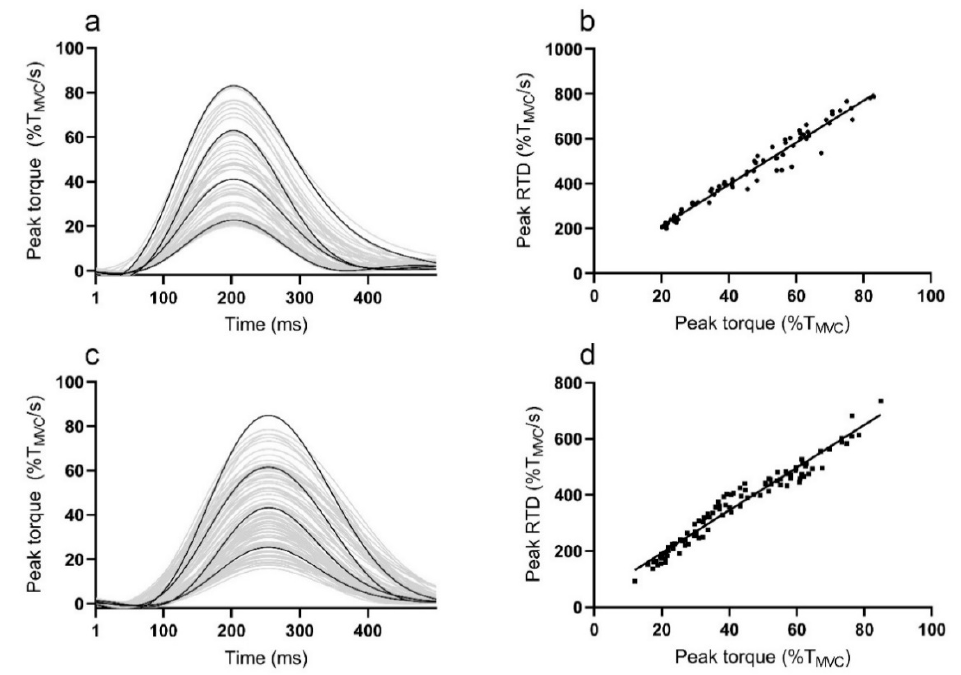
Figure 3. Sample recording of rapid torque pulses of ( a ) elbow extensors and ( c ) volar flexors to a variety of amplitudes. Rate of torque development scaling factor (RTD-SF) plot of ( b ) elbow extensors ( b ) and ( d ) volar flexors with data points taken from the peaks of the preferred arm.